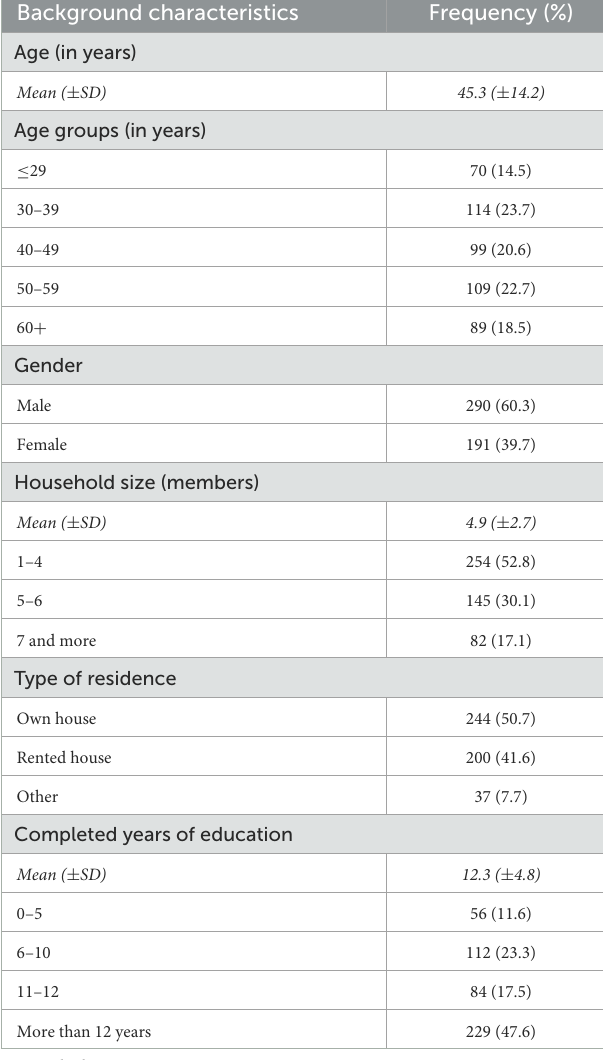
TABLE 1 Frequency and percentage distribution of respondents’ background characteristics ( N =